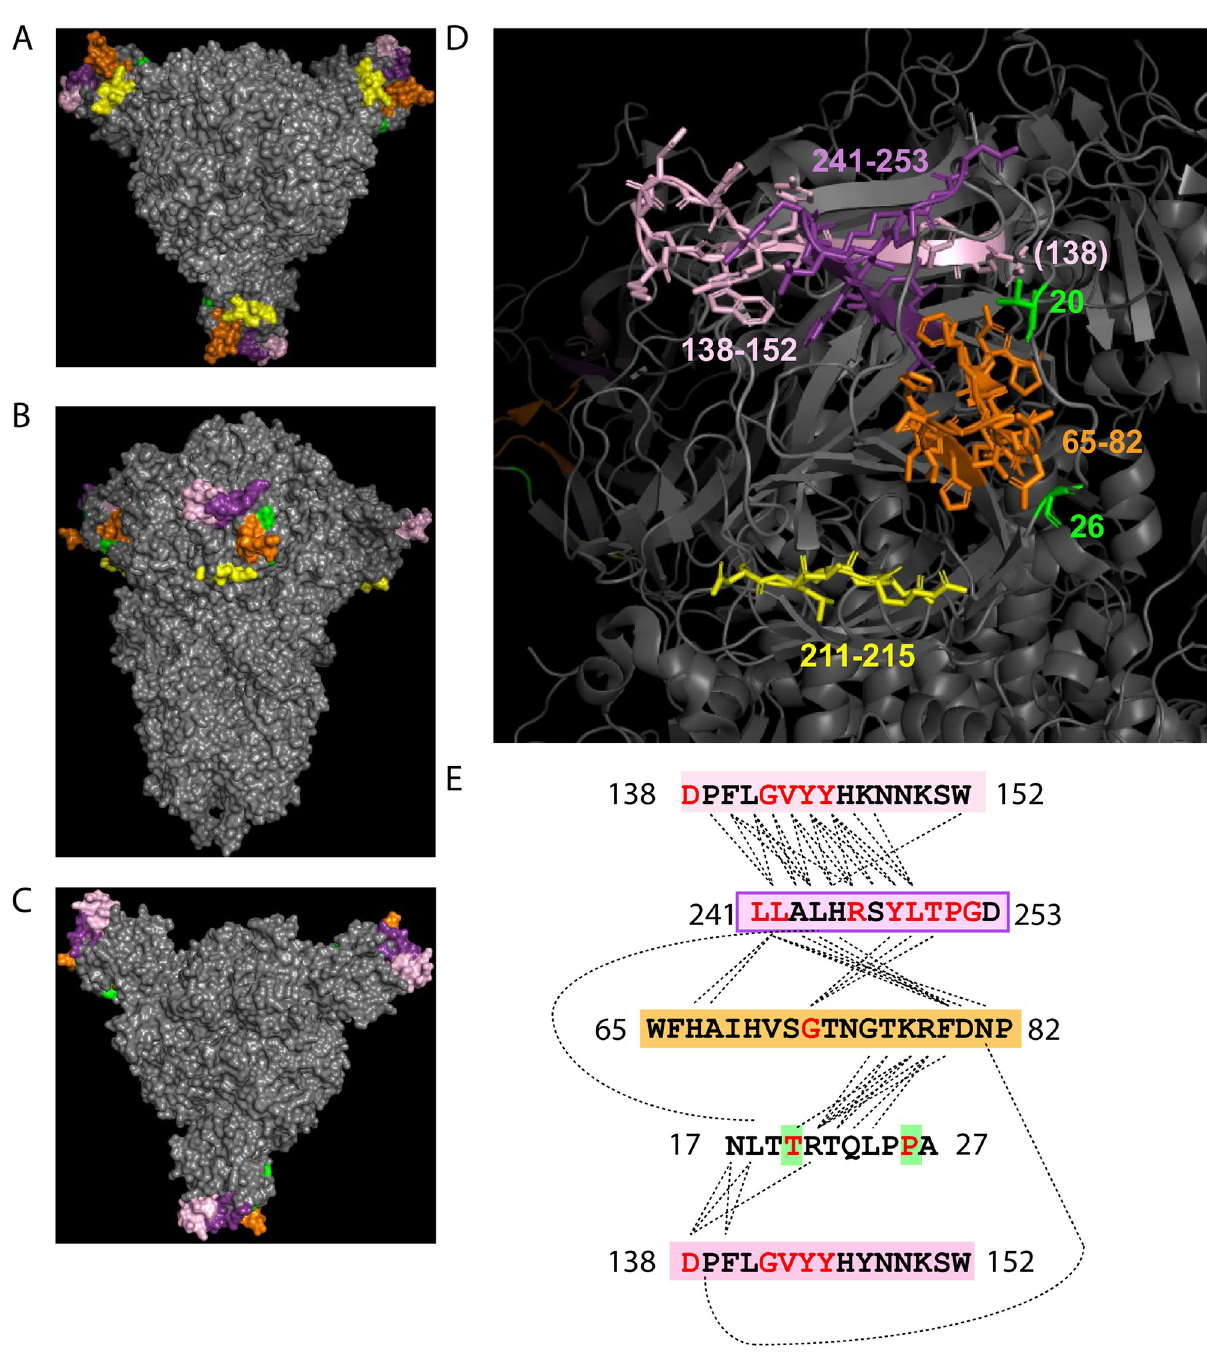
Fig 6. Mapping of Spike NTD covariant residues and deletion identified in clinical and pan analyses and also found in dominant circulating SARS-CoV-2 variants. (A-C) The top, side, and bottom PDB structure (7JJI.PDB) of the Spike homotrimer shows the position of these residues. Residues are colored by position in the NTD. (D) Labeled regions and residue numbers of regions are indicated. Amino acid structures are shown for highlighted residues. (E) The sequences of highlighted residues are shown. Residues predicted to directly interact at the molecular level in the PBD are linked by dotted lines. Covariant residues found in both Pan and Clinical covariant analyses and dominant SARS-CoV-2 variants are colored red.